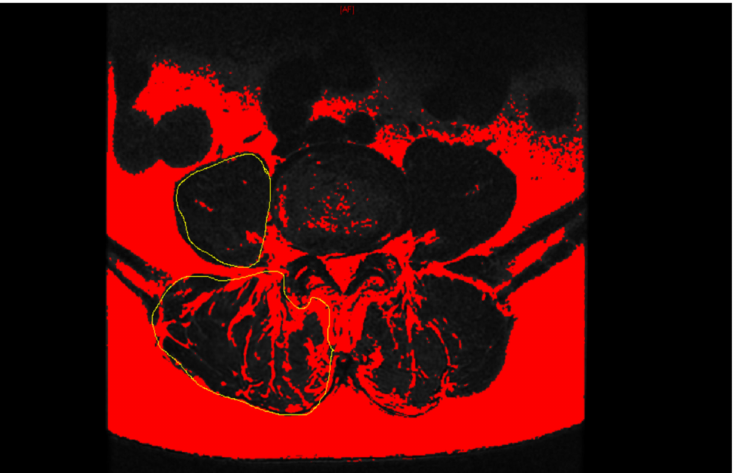
Figure 4. The tCSA of PSM was measured by drawing the outline of the fascial–muscle boundary using the ROI at the level of the inferior vertebral endplate of L4 on axial T2-weighted MRI. Measure- ment of fCSA of PSM was performed using a threshold method. tCSA = total cross-sectional area, PSM = paraspinal muscle, ROI = region of interest, and fCSA = functional cross-sectional area.